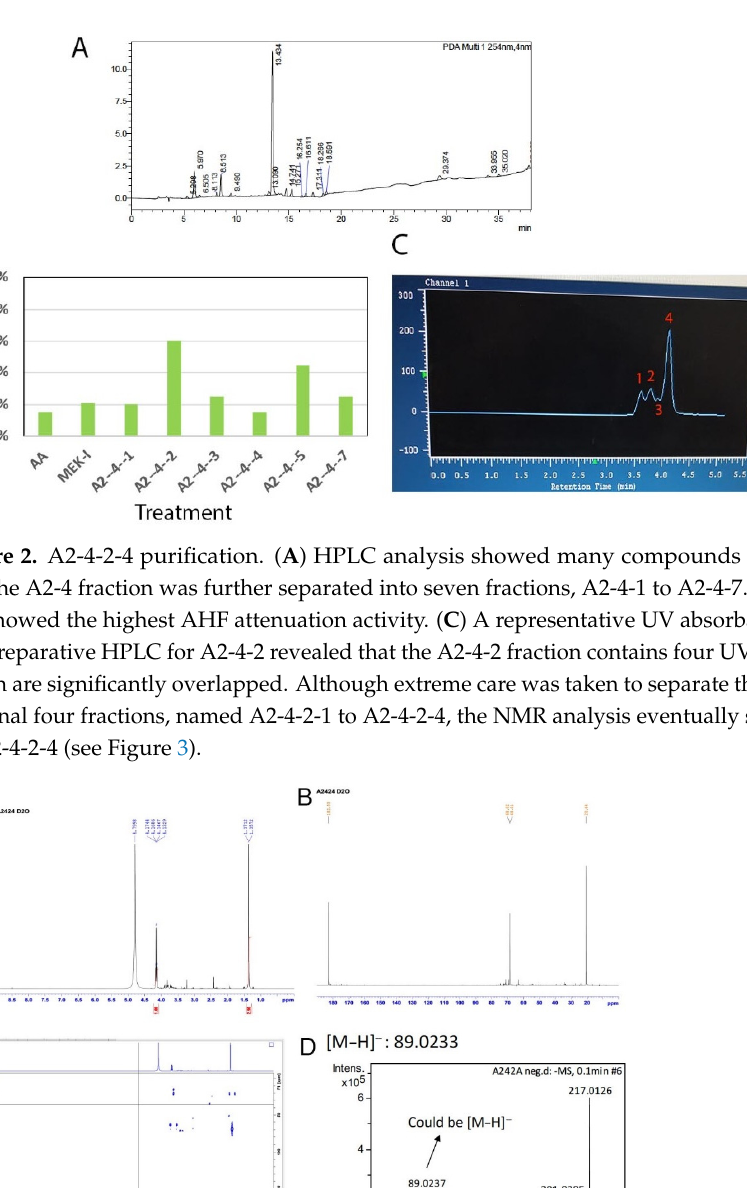
A2-4-2-4 is 89.0233 (C 3 H 6 O 3